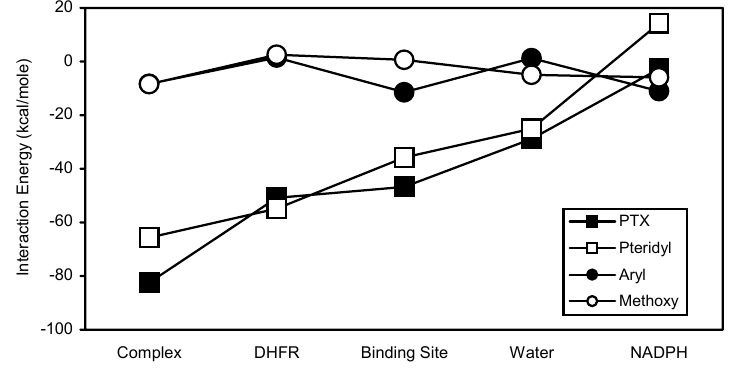
Figure 2. Comparison of interaction energy analyses of PTX and its substructural regions. greatest stability followed by the interactions with DHFR, binding site, water, and NADPH, respectively. The pteridyl subregion was the major stabilizing contributor to the PTX interactions. The aryl and methoxy substructural regions contributed much less to the stability of the PTX